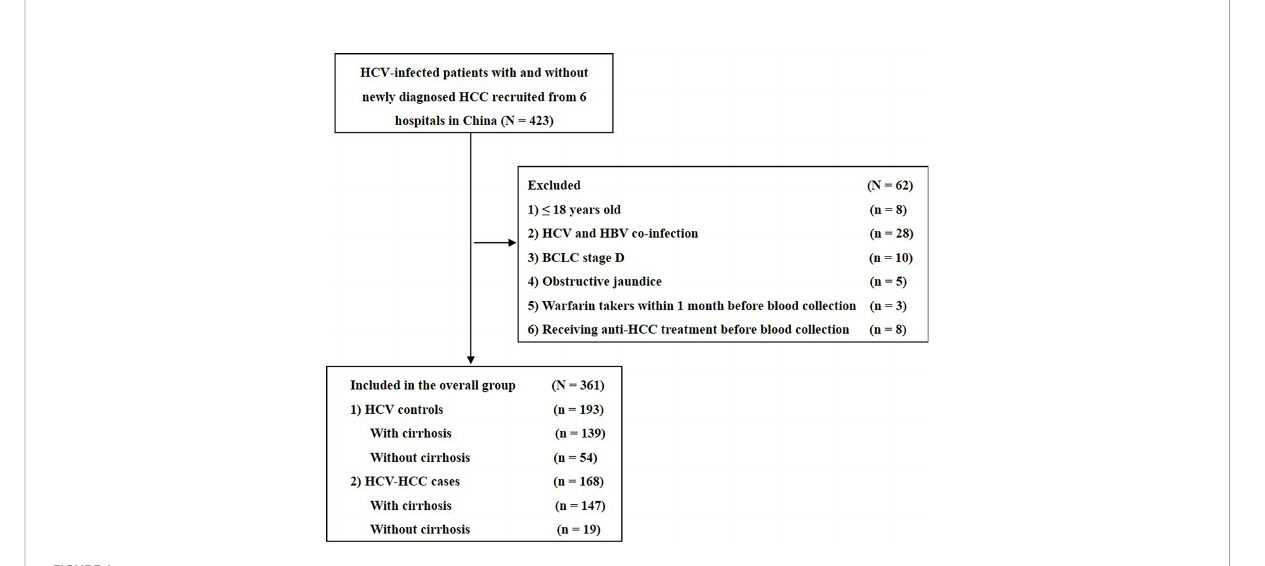
FIGURE 1 Flow chart of the